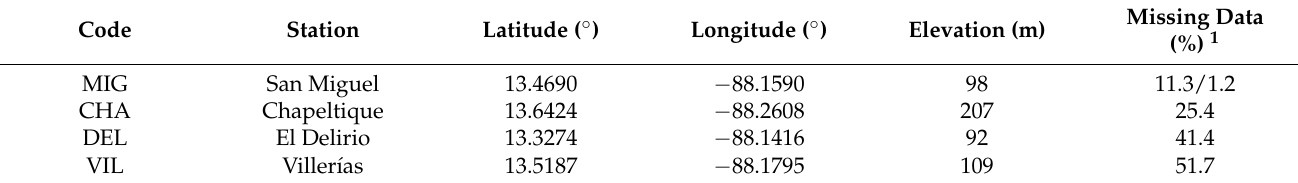
Table 1. Summary of the weather stations used in this